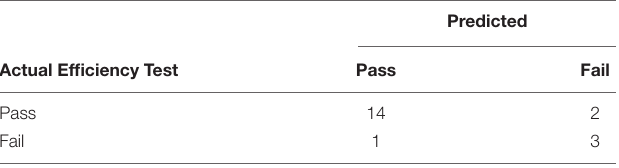
TABLE 1 | The confusion matrix of the 2D Machine Vision System (MVS) classification results.